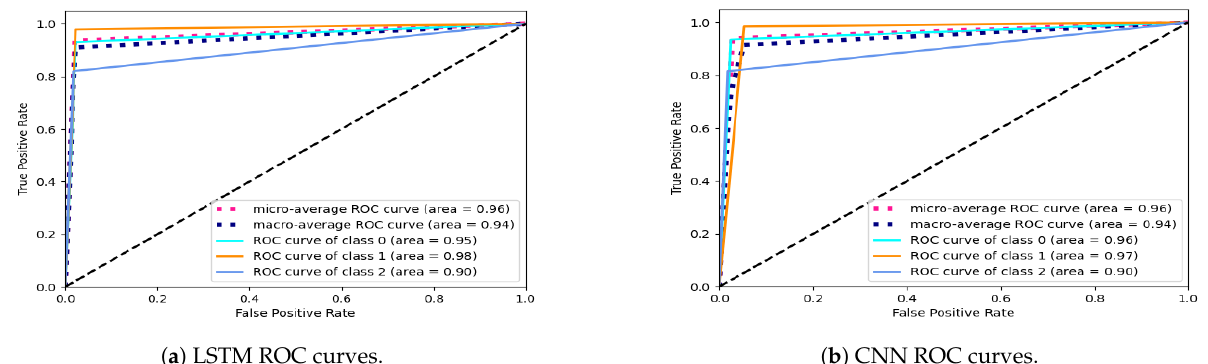
Figure 12. ROC curves computed for both classification frameworks, where class 0 corresponds to no activity, class 1 to walking, and class 2 to